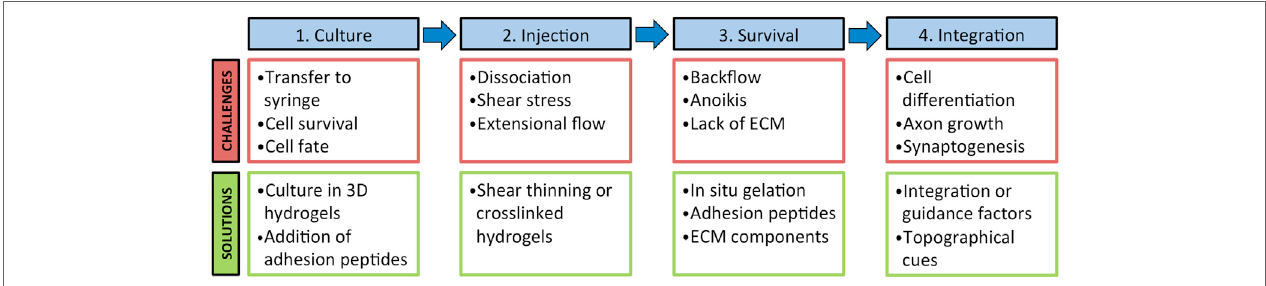
FiGURe 3 | Biomaterials can be used to address challenges at multiple stages of the cell transplantation paradigm. 1. Biomaterials can be used to prime cells in culture prior to injection to guide cell fate and limit death during transfer to a syringe. 2. The use of a shear thinning or crosslinked hydrogel can decrease mechanical stress that cells undergo during processing and injection. 3. Biomaterials can aid in cell retention at the injection site and increase cell survival with the addition of adhesion peptides and ECM components. 4. Long-term cell integration can be supported with a biomaterial with factors and topographical cues for cell differentiation, axon guidance, and synapse